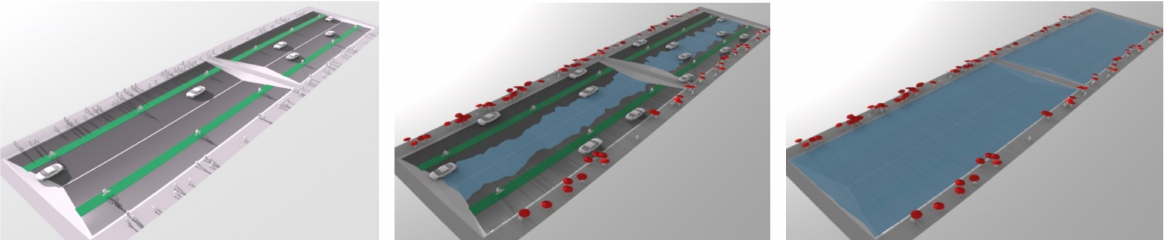
Figure 5. Street casement graded to hold storm water in the road casement in non-flood to major flood events. Image by authors using 3ds Max.